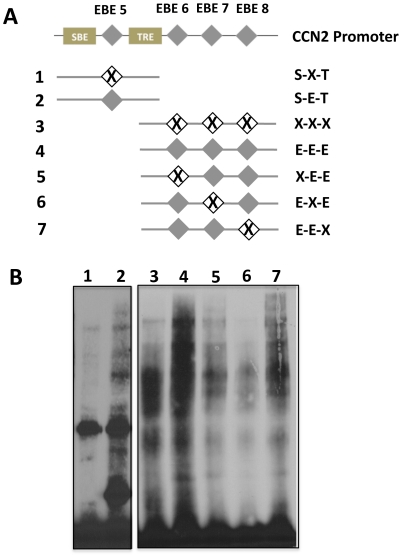
Mutation of EBE sites prevents protein complex binding.(A) Electro-mobility shift assays (EMSA) probes were created that were homologues to the CCN2 promoter and contained either mutated or unmutated EBE sites (#5-8) as indicated. Each probe was dsDNA and 5′ biotinylated. (B) Electro-mobility shift assays (EMSA) from nuclear lysates were generated from osteoblasts that were treated with TGF-β1 (5 ng/ml) for 2 hrs. Nuclear protein binding to the wild type and mutated EBE sites in the CTGF promoter was assessed using 5 µg of nuclear lysates. The lane number above each well corresponds to the probe used for that reaction. The experiment was repeated four times with similar results.